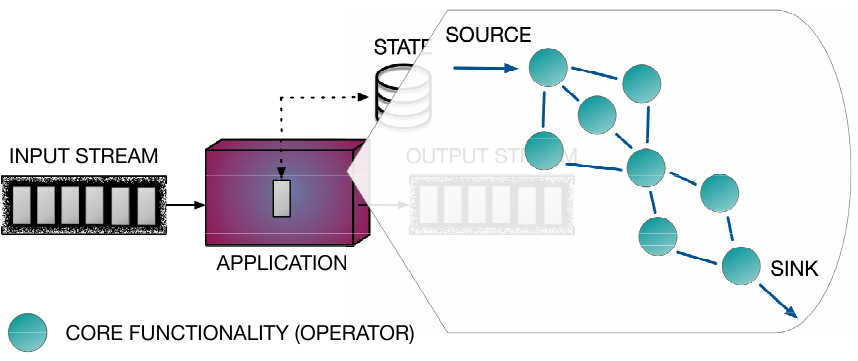
Figure 3. Data-flow graph representation of a stream processing application. The processing pipeline is defined by the operators (nodes) in the graph. Their business logic is executed on every stream item traversing the corresponding path in the graph. The application logic applied to each flowing element results from the execution of successive transformations in the